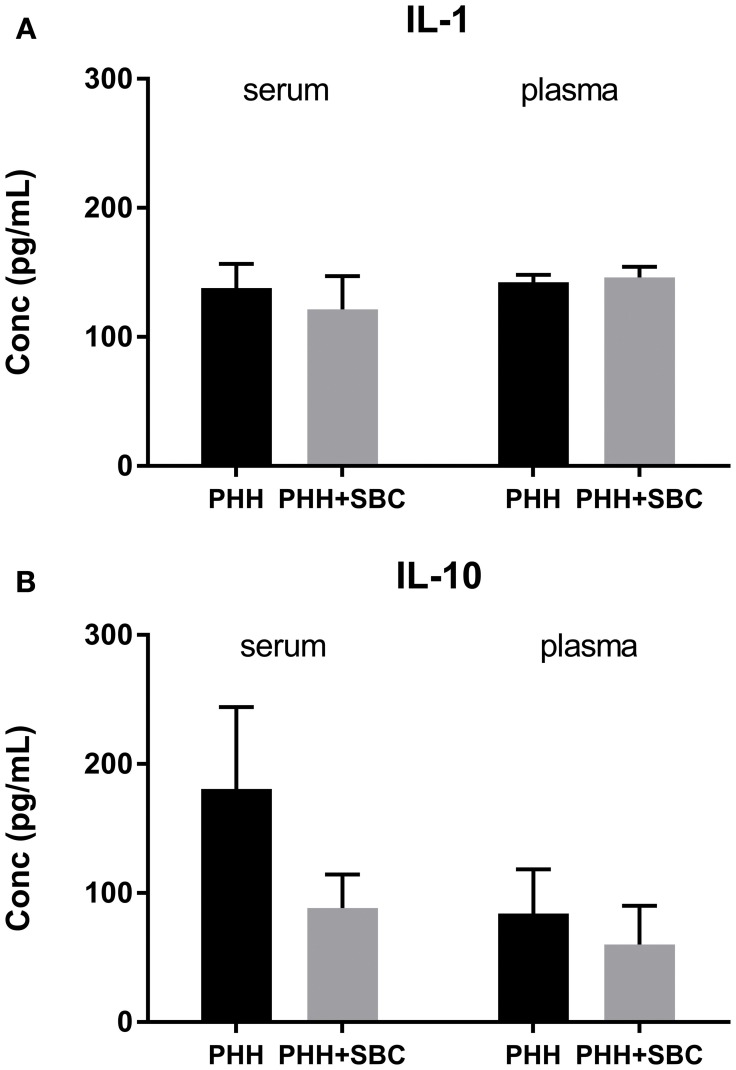
Blood serum and plasma levels of IL-1 (A) and IL-10 (B). PHH group n = 13; PHH+SBC group n = 12. Student's t-test did not detect statistically significant differences between groups.